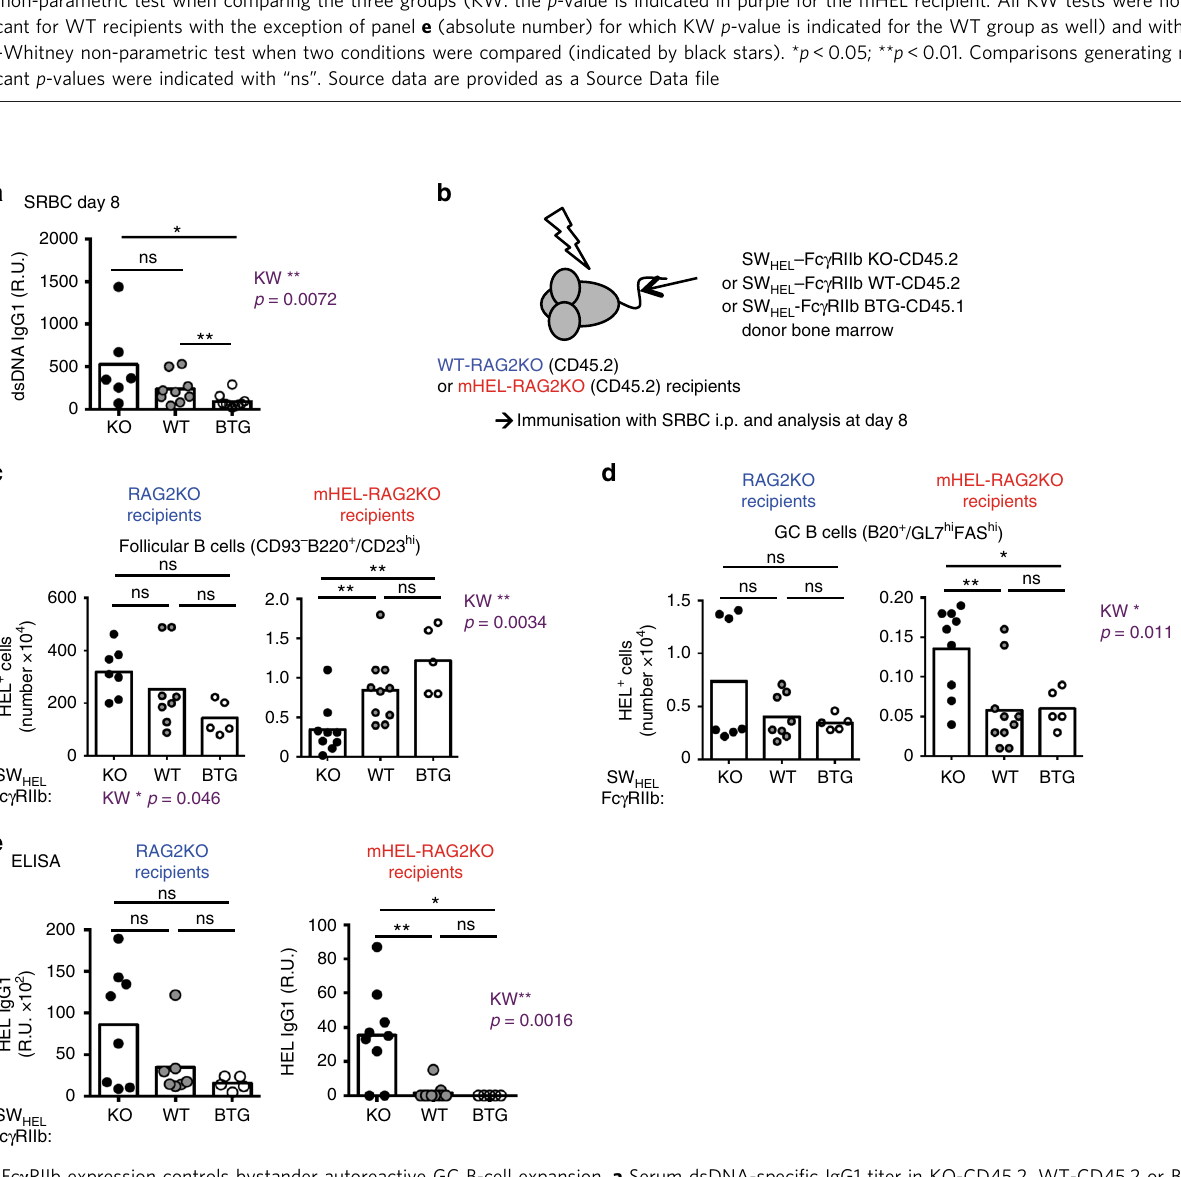
Fig. 6 Fc γ RIIb expression controls bystander autoreactive GC B-cell expansion. a Serum dsDNA-speci fi c IgG1 titer in KO-CD45.2, WT-CD45.2 or BTG- CD45.1 mice immunised for 8 days with SRBC. (R.U. = relative units) b RAG2KO and RAG2KO-mHEL recipients (both CD45.2) were irradiated and reconstituted with bone marrow from SW HEL -Fc γ RIIb KO-CD45.2, SW HEL -Fc γ RIIb WT-CD45.2 or SW HEL -Fc γ RIIb BTG-CD45.1 donor mice. Post reconstitution, chimeras were immunised with SRBC intraperitoneally and analysed 8 days later. c Number of HEL-speci fi c follicular B cells in RAG2KO (left panel) and RAG2KO-mHEL (right panel) recipient mice. d Number of HEL-speci fi c GC B cells in RAG2KO (left panel) and RAG2KO-mHEL (right panel) recipient mice. e Serum HEL-speci fi c IgG1 titer in RAG2KO (left panel) and RAG2KO-mHEL (right panel) recipient mice. Two pooled experiments are shown. RAG2KO recipients: n = 5 – 8 mice per group; RAG2KO-mHEL recipients: n = 5 – 10 mice per group. The mean is represented and each dot corresponds to an individual mouse. The p -values were determined with the Kruskal – Wallis (KW) non-parametric test when comparing the three groups (KW: the p -value is indicated in purple for the RAG2KO-mHEL recipient. All KW tests were not signi fi cant for RAG2KO recipients with the exception of panel c for which KW p -value is indicated for the RAG2KO group as well) and with the Mann – Whitney non-parametric test when two conditions were compared (indicated by black stars). * p < 0.05; ** p < 0.01. Comparisons generating non-signi fi cant p -values were indicated with “ ns ” . Source data